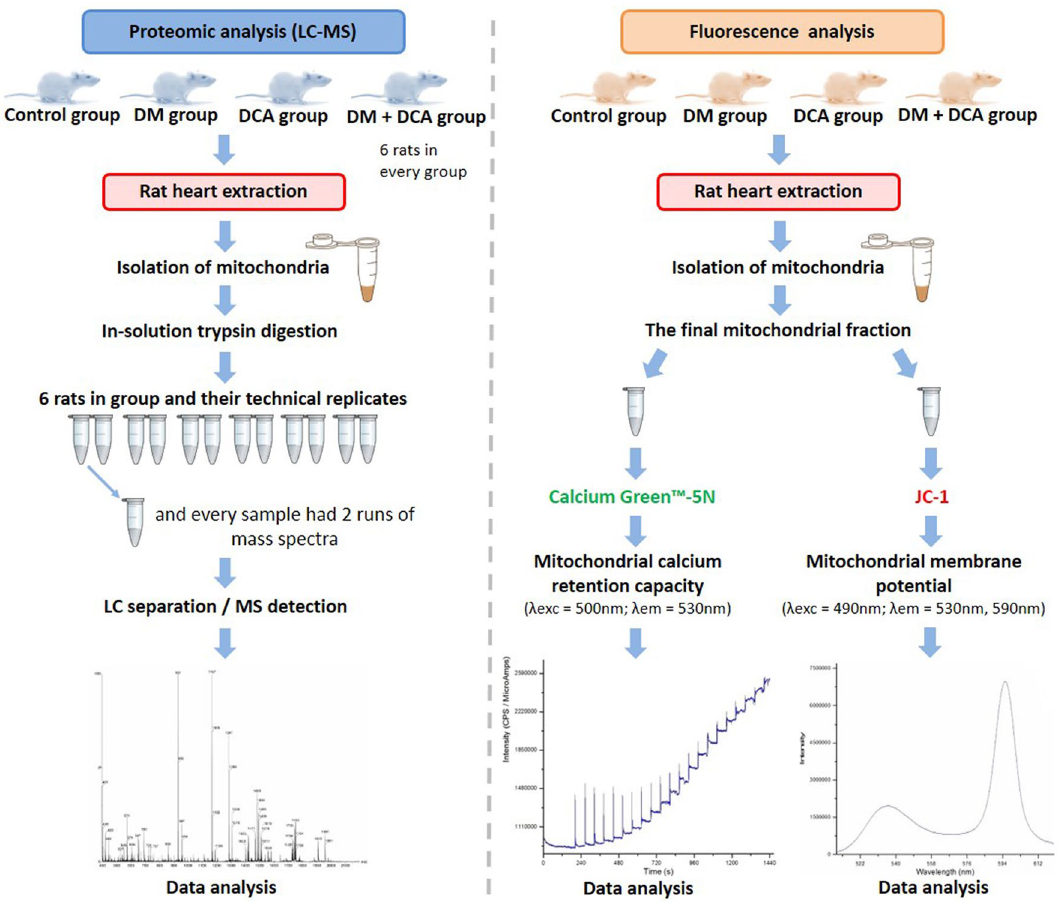
Figure 8. Overview of the experimental workflow. This figure was made in Microsoft PowerPoint (Microsoft PowerPoint for Microsoft 2016 MSO (Version 2207 Build 16.0.15427.20166),